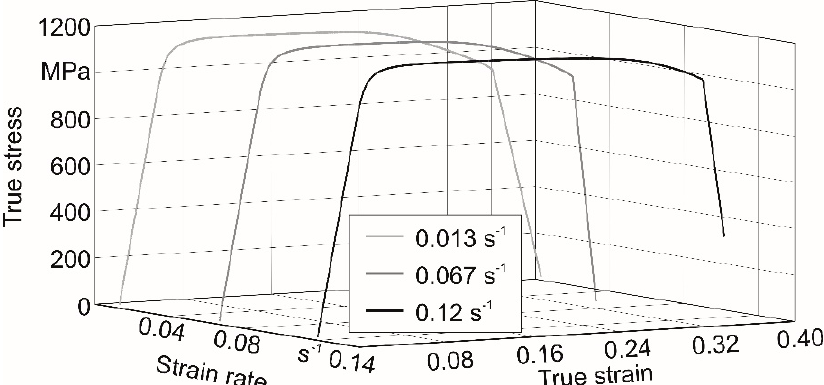
Figure 1. Flow curves of Ti-1023 titanium alloy in standardized tensile tests at di ff erent strain rates.